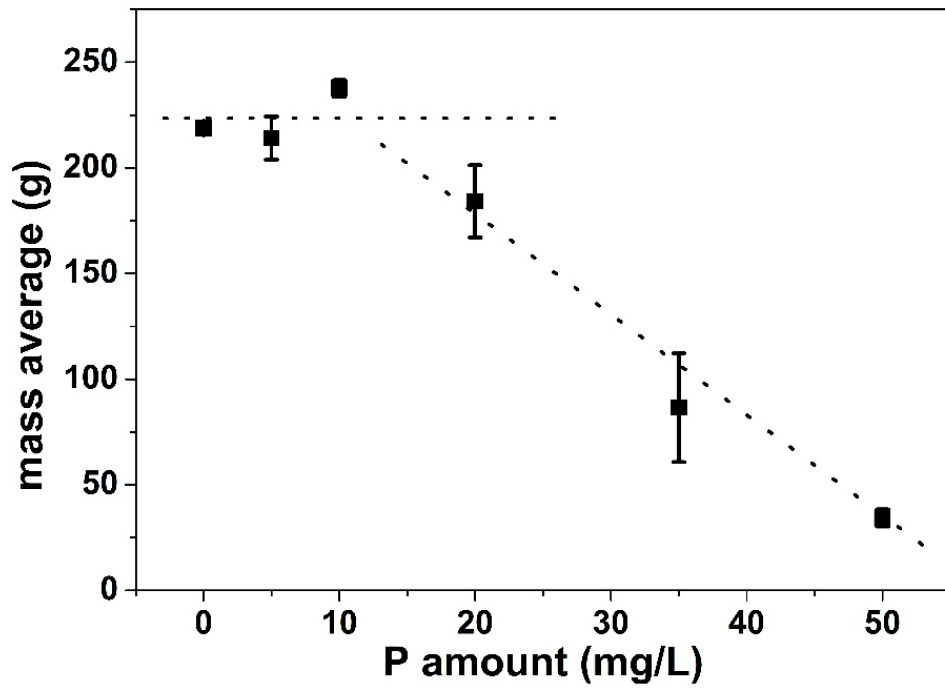
Figure 2. Variation of the measured total deposited mass within the plate heat exchanger (PHE) as a function of the added P at an average calcium concentration equal to <[Ca]> = 101.02 ± 2.06 mg/L and 0.5% ( w / v ) (WPI) solution as a model fluid. Dotted lines are given for guiding eyes.